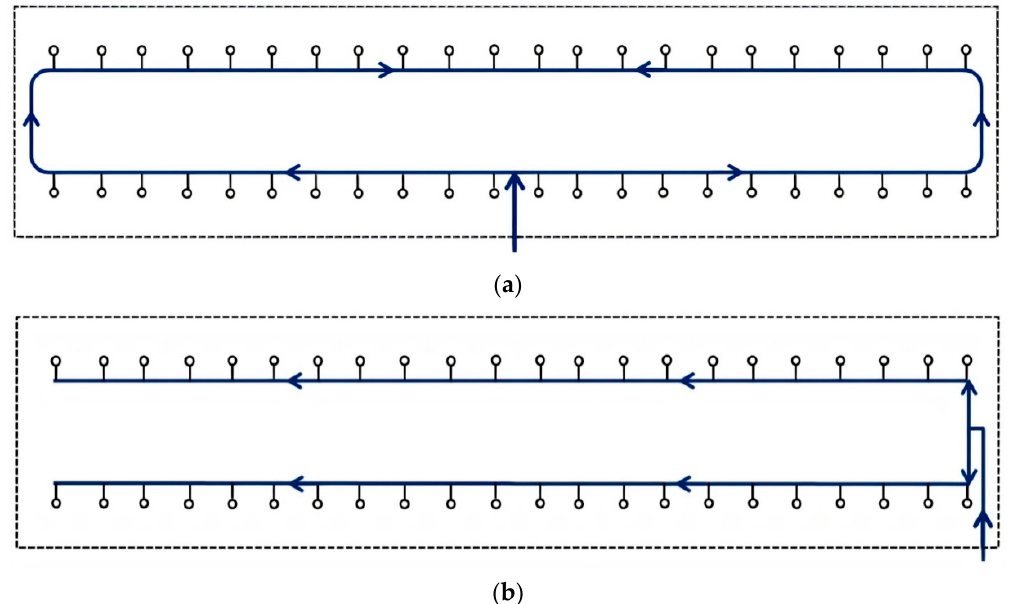
Figure 1. Examples of two configurations of a drinking water distribution system within a conventional pig building (concrete/slatted floors): ( a ) looped, ( b ) branched. Main pipelines are represented by blue solid lines. Arrows indicate the direction of water flow. Drinkers are represented by open circles. Walls of the building are represented by dashed lines.